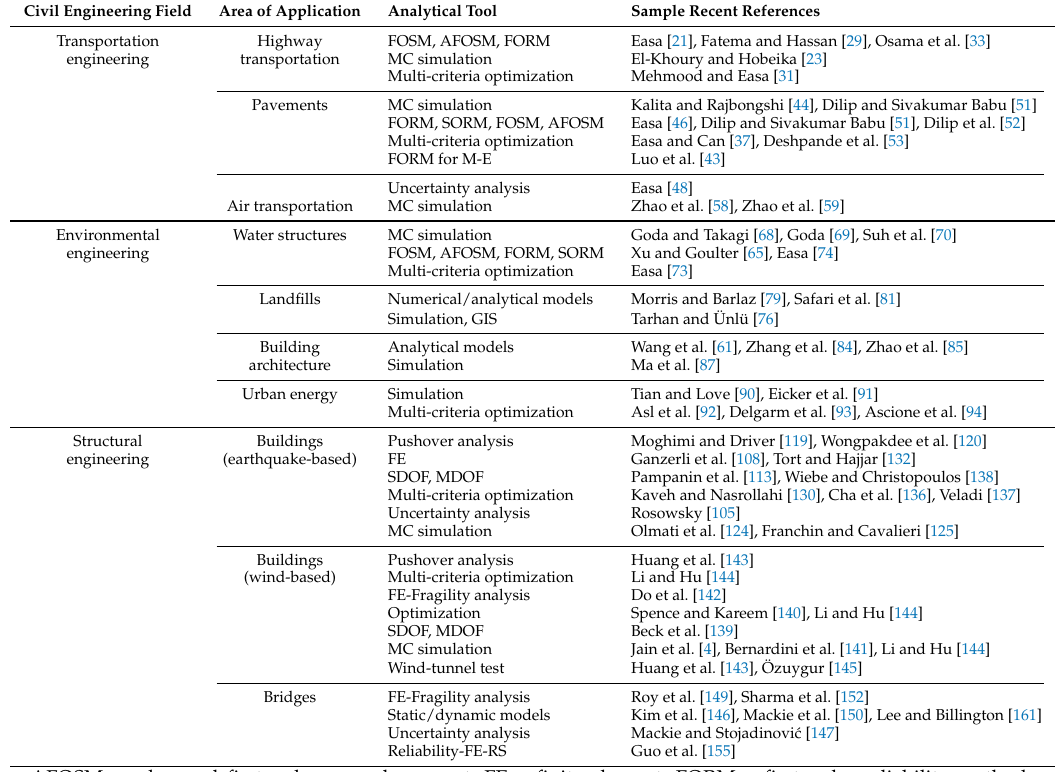
Table 2. Main analytical tools used in performance-based analysis